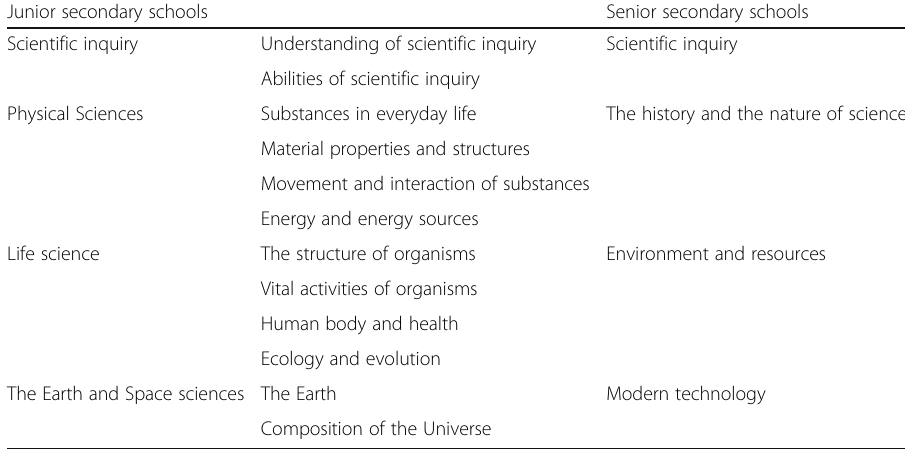
Table 3 The learning areas and categories of the RBAAs for junior and senior secondary